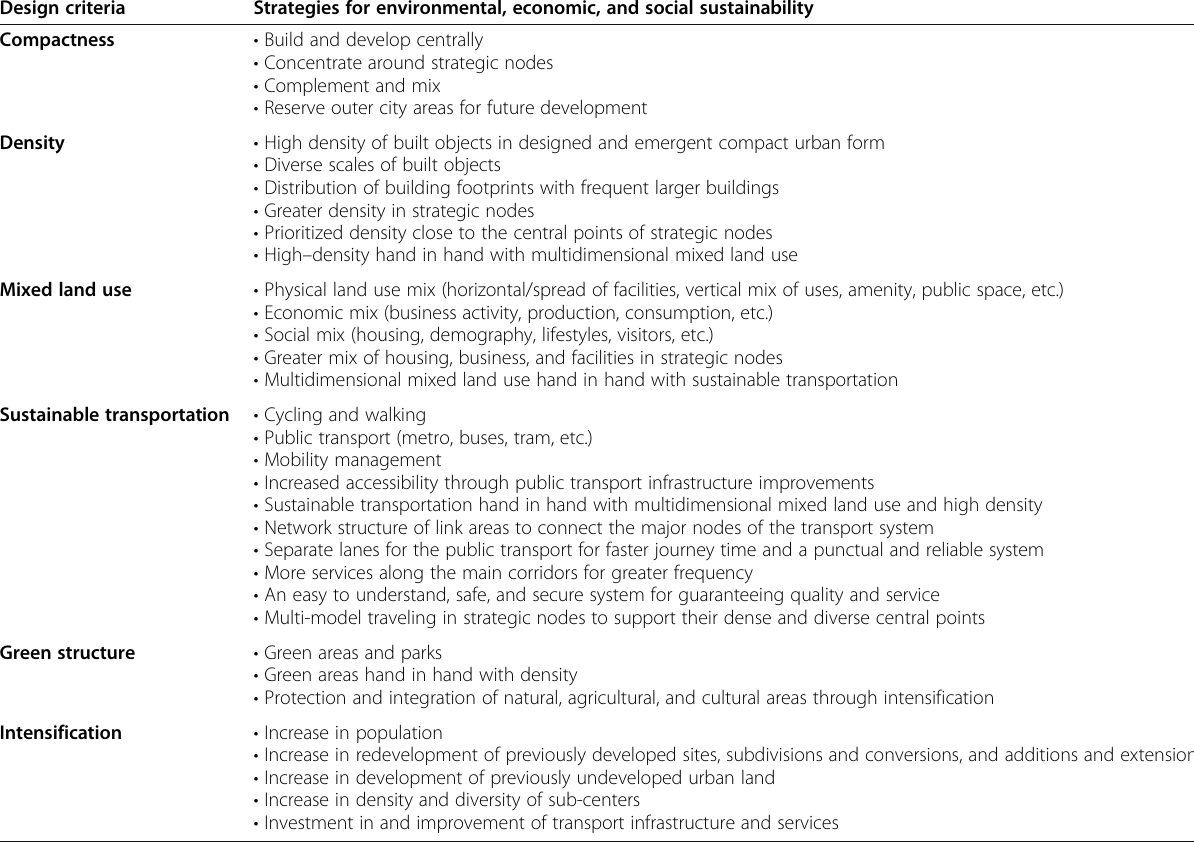
Table 2 The design criteria and strategies of the compact city for achieving the goals of sustainability Design criteria Strategies for environmental, economic, and social